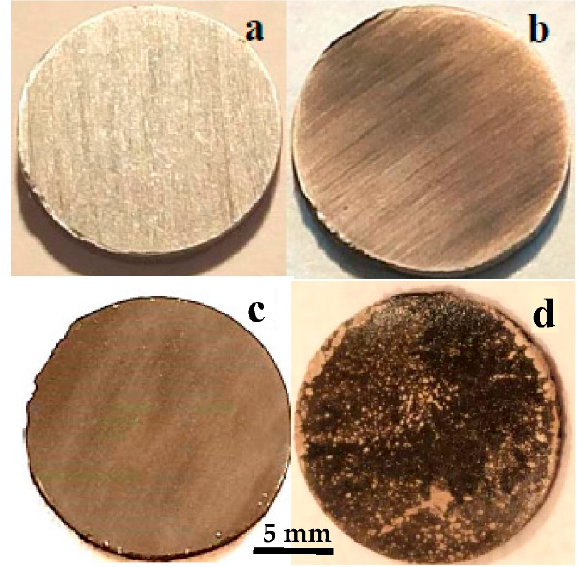
Figure 2. Optical images showing the evolution with carbonatation time of Mg disks: ( a ) before immersion, and after ( b ) 15 min, ( c ) 1 h, ( d ) 1 week immersion times.